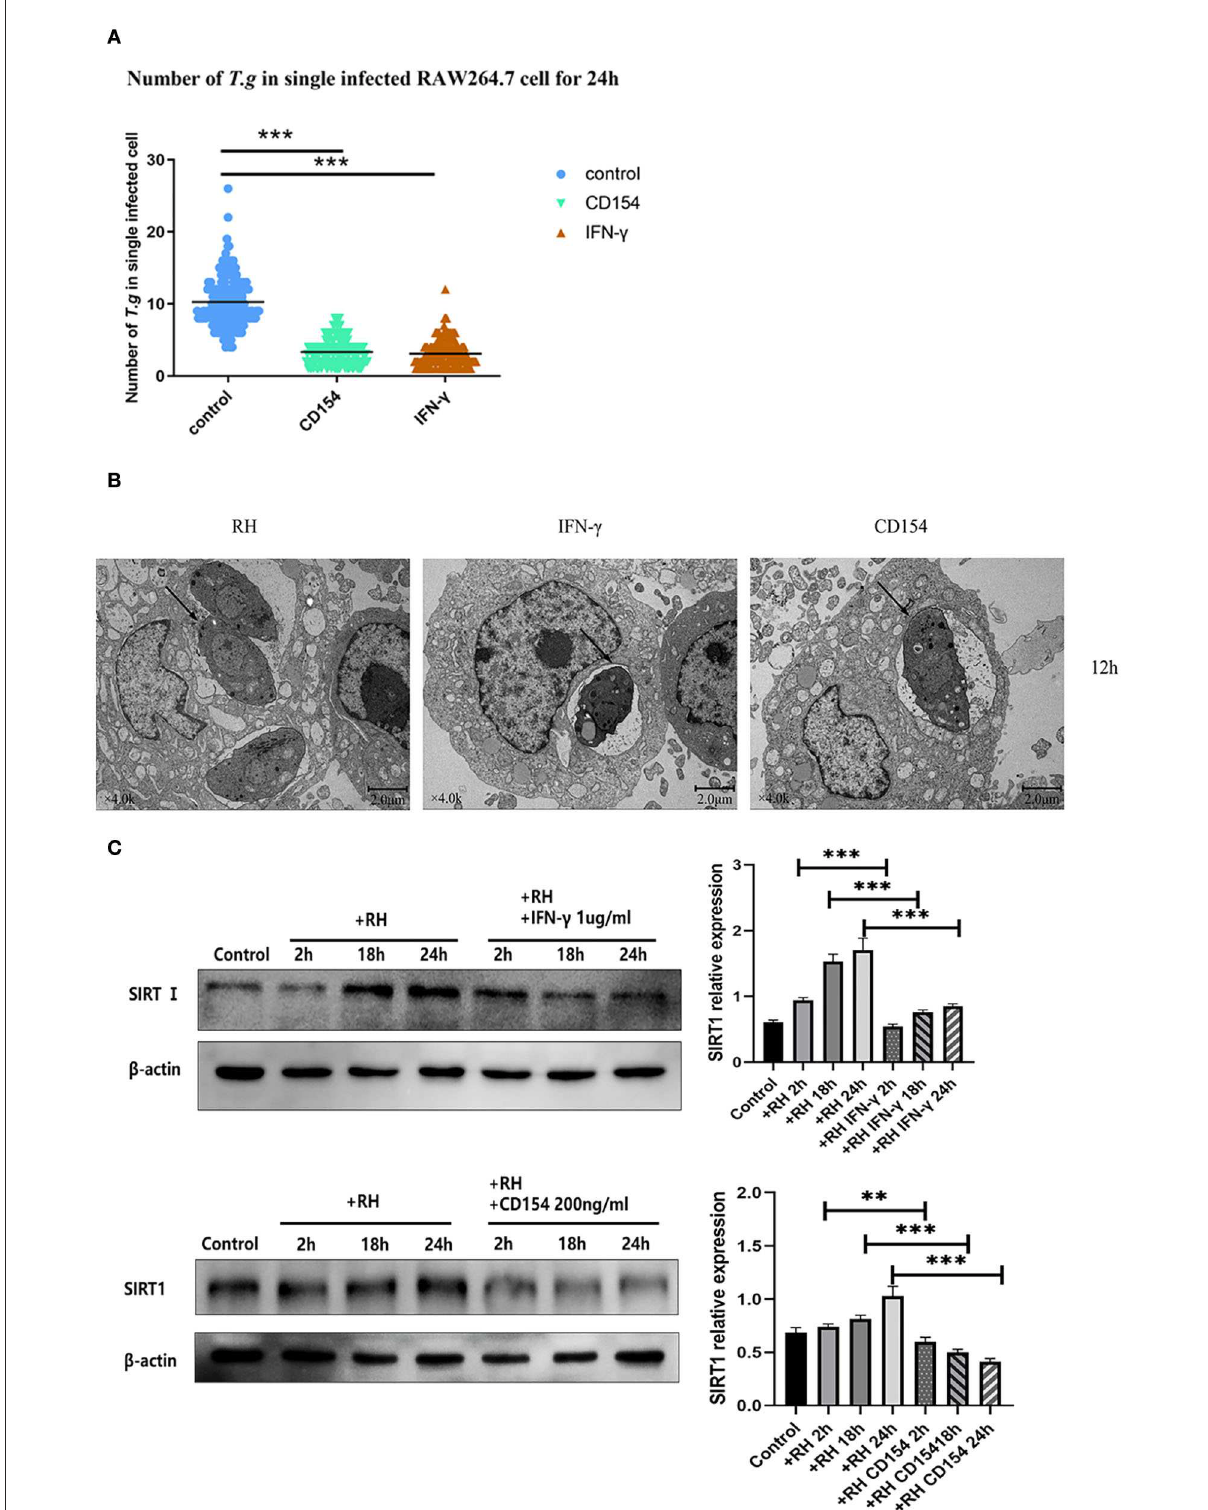
FIGURE3 Intracellular growth of RH tachyzoites inside mouse macrophages with interferon gamma (IFN- γ ) or CD154 in vitro and Sirtuin 1 (SIRT1) regulation-infected macrophages stimulated with IFN- γ and CD154 at different time points. RH tachyzoites were harvested to infect RAW 264.7 mouse macrophages at an infection ratio of 5:1 (parasite/host cell) for 2h, followed by the removal of excess parasites and incubation with